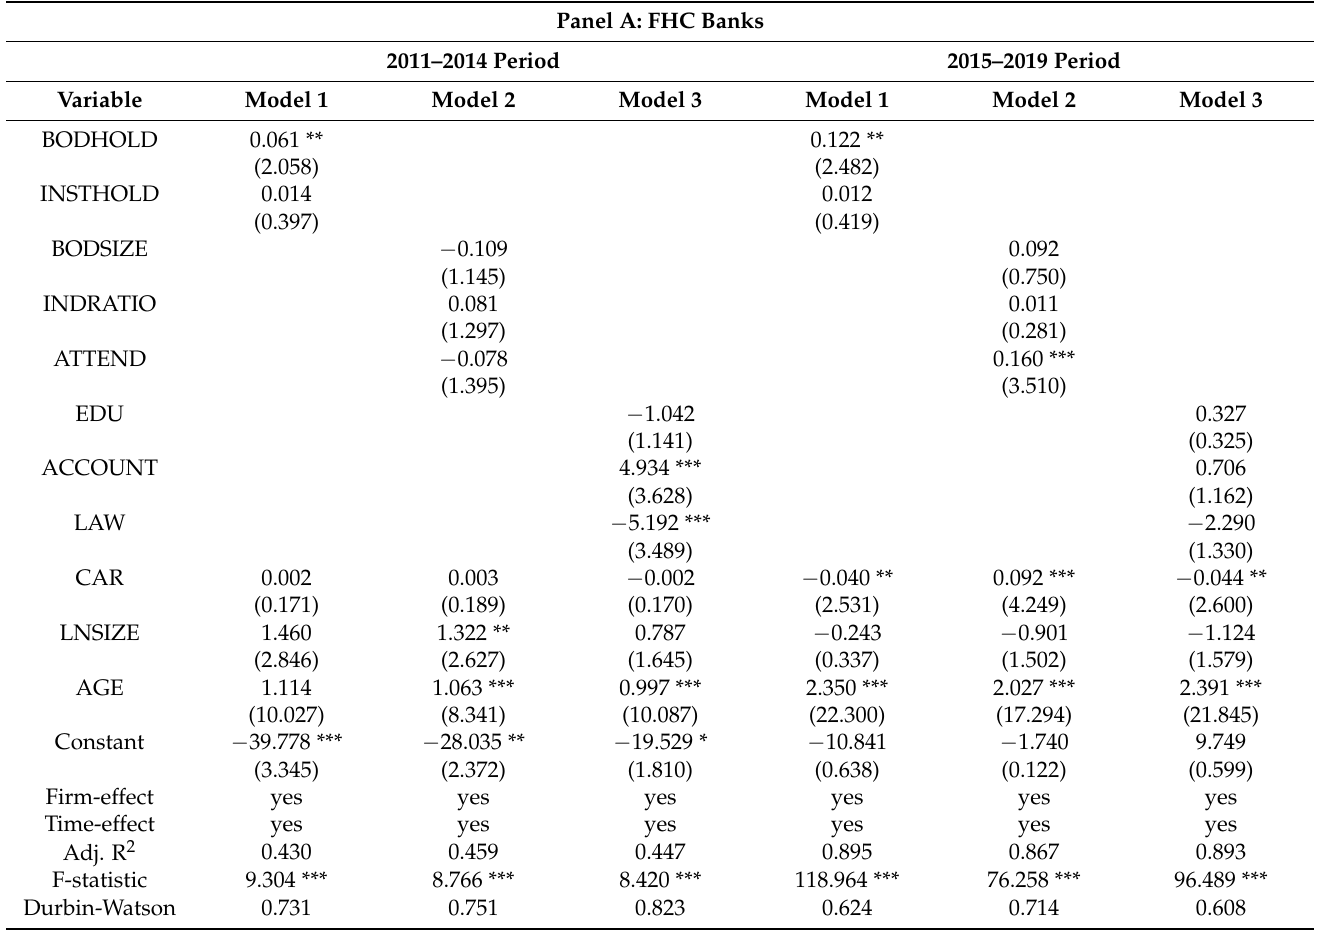
Table 8. The correlation between corporate governance and financial innovation for FHC and non- FHC banks. Panel A: FHC Banks 2011–2014